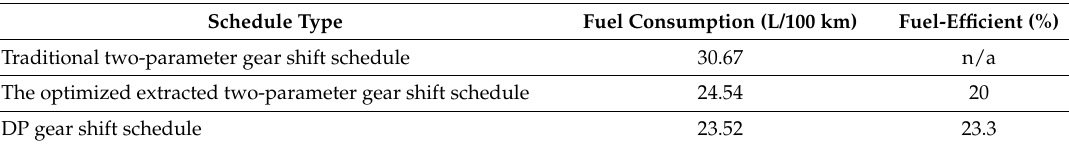
Table 1. Simulation result of fuel consumption.